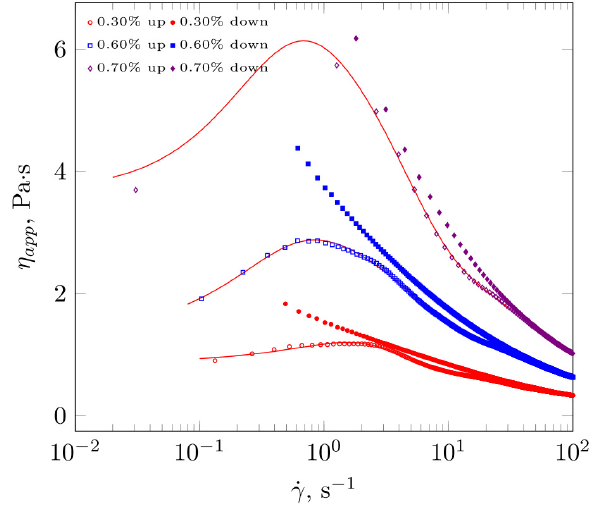
Figure 5. Apparent viscosity dependence on shear rate for increasing (up) and decreasing (down) shear rate values regarding Plantago ovata husk extracts.